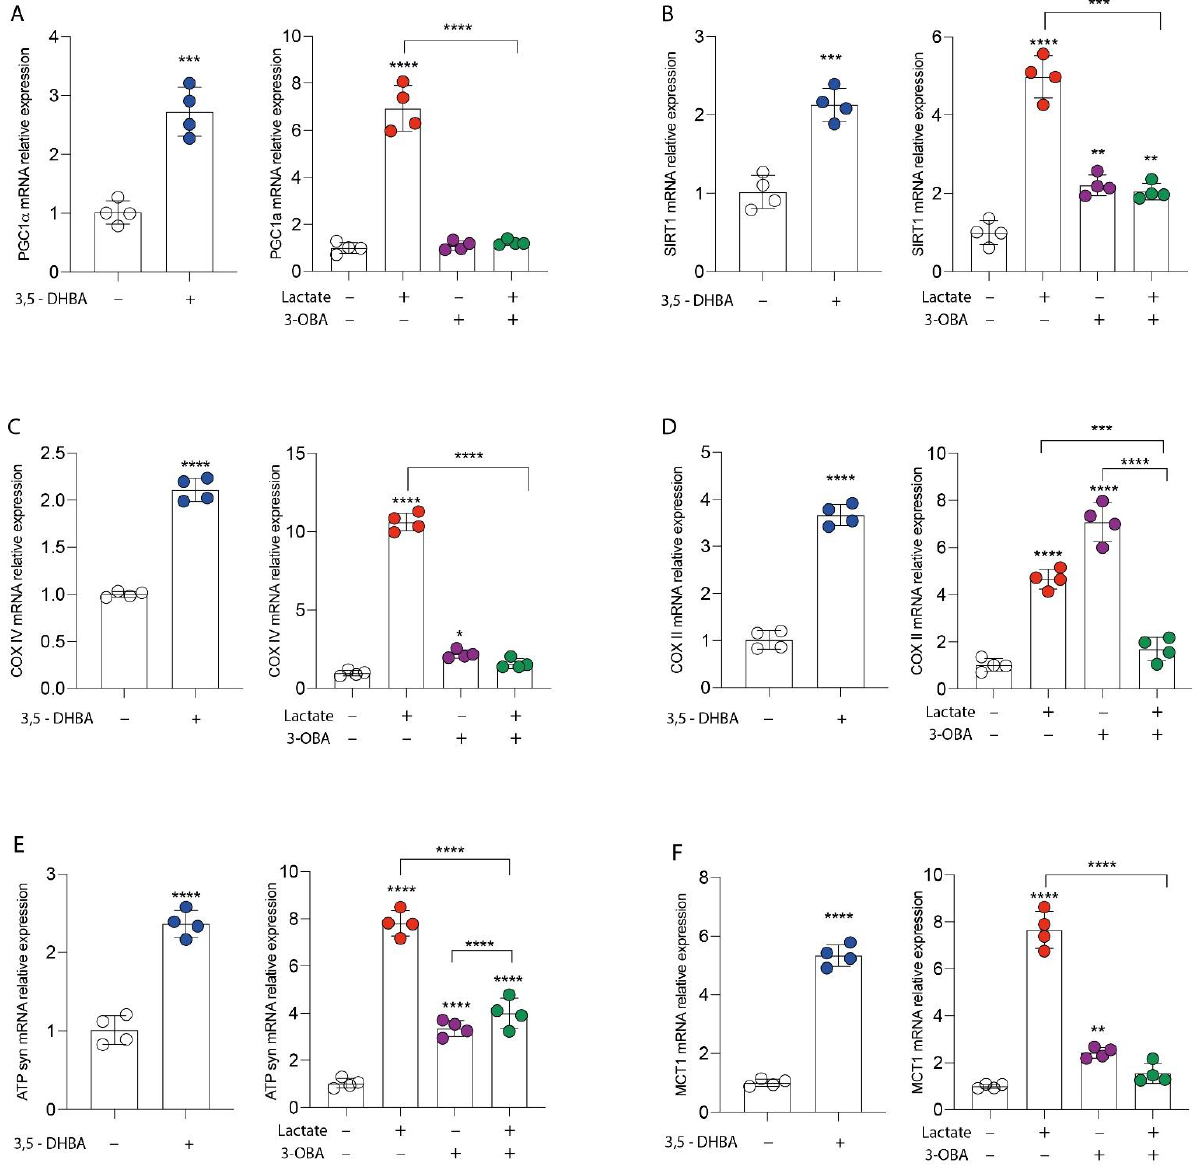
Figure 2. GPR81 modulates mitochondrial metabolism gene expression. Evaluation of relative mRNA expression levels of ( A ) PGC1alpha, ( B ) SIRT1, ( C ) COX IV, ( D ) COX II, ( E ) ATPsyn, ( F ) MCT1, following 24 h of lactate (20 mM), 3,5-DHBA (150 µ M) and 3-OBA (3 mM) exposition, analyzed by real-time PCR. The calculated value of 2 - ΔΔCt in untreated controls is 1. Data are expressed as mean ± SD of at least four independent experiments. * p < 0.05; ** p < 0.005; *** p < 0.001; **** p < 0.0001.